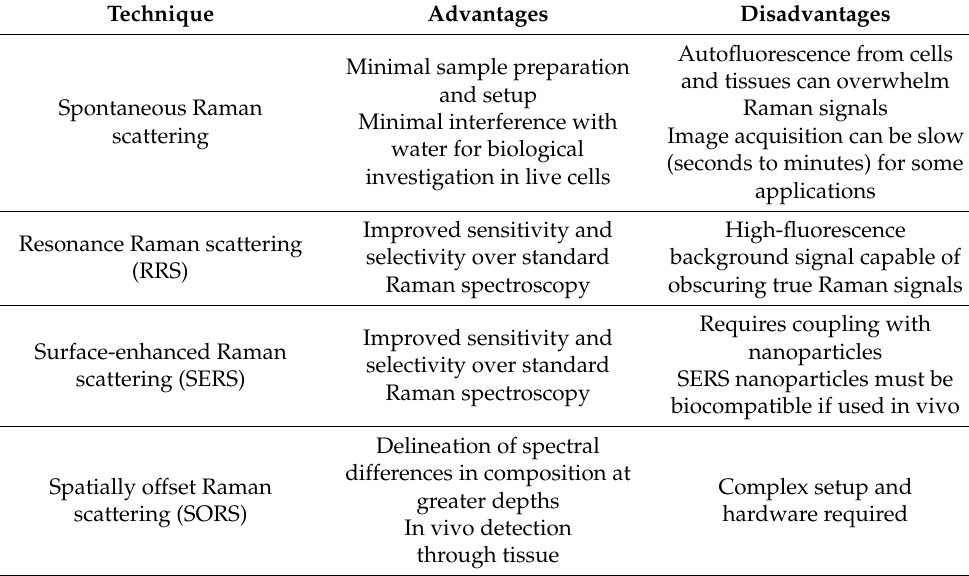
Table 3. Advantages and disadvantages of Raman spectroscopy and its subtypes.